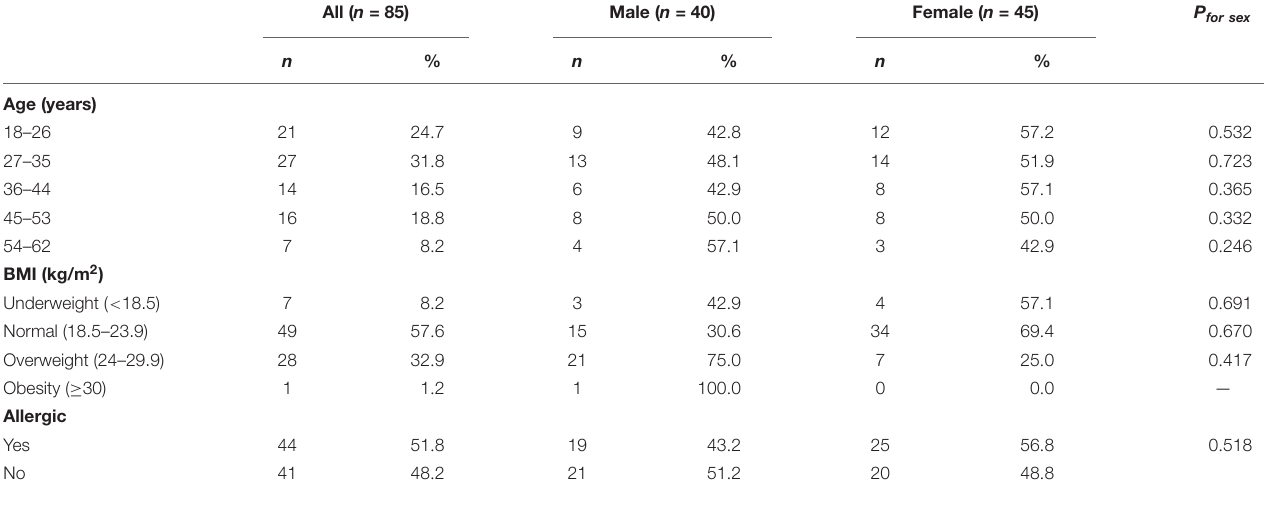
TABLE 1 | Characteristics of study